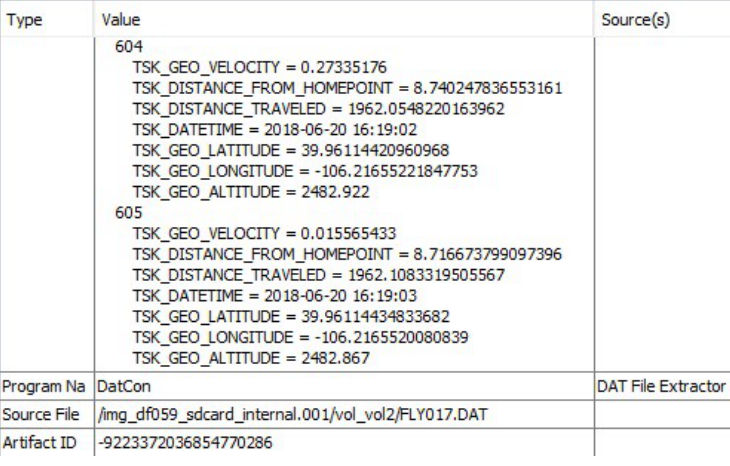
Figure 3. Autopsy decrytped and parsed 605 waypoints out of 17,998 waypoints.